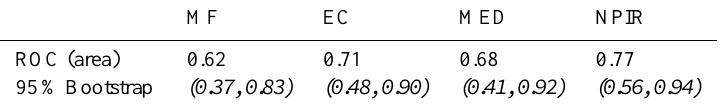
Table 2. Area under the ROC curve with a 95%